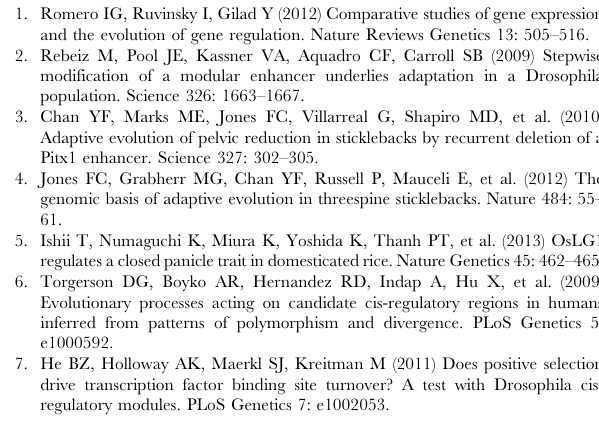
Figure S8 Heterogeneity in the mode of regulatory evolution across the genes of a pathway has little impact on inference of evolutionary histories from expression data. Each trace reports the results of inference of the evolutionary history of regulation of a yeast pathway of size 100, from expression data simulated under a Brownian motion model in which the rate of regulatory evolution for each gene was drawn branch leading to S. paradoxus , increased by a factor of 5 for a subset of pathway genes. The x axis reports the fraction of genes in